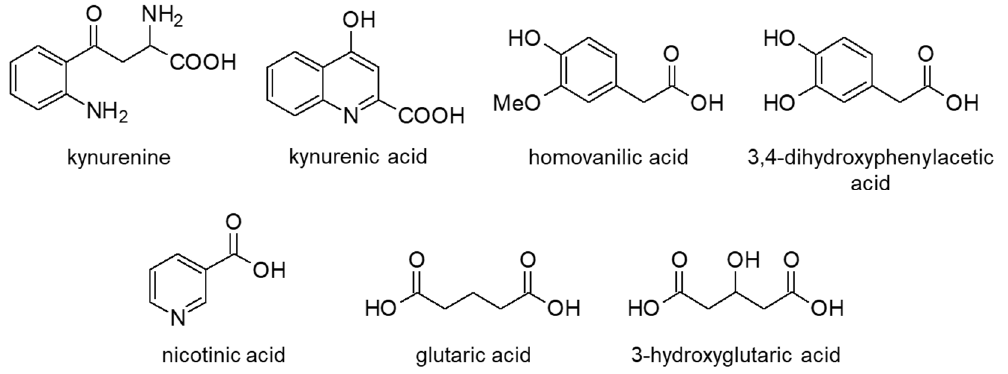
Figure 7. Chemical structures of amino acid metabolites.